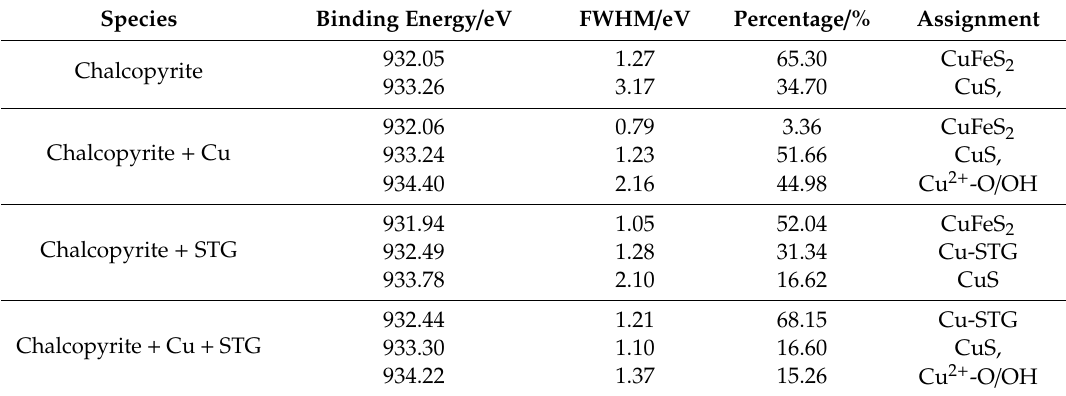
Figure 7. Cu 2p XPS spectra of chalcopyrite ( a ), chalcopyrite + CuSO 4 ( b ), chalcopyrite + STG ( c ) and chalcopyrite + CuSO 4 + STG ( d ); (c(CuSO 4 ) = 1 × 10 − 3 mol / L, c(STG) = 1.5 × 10 − 3 mol / L). Table 3. The parameters and assignment of high-resolution Cu 2p3 / 2 XPS